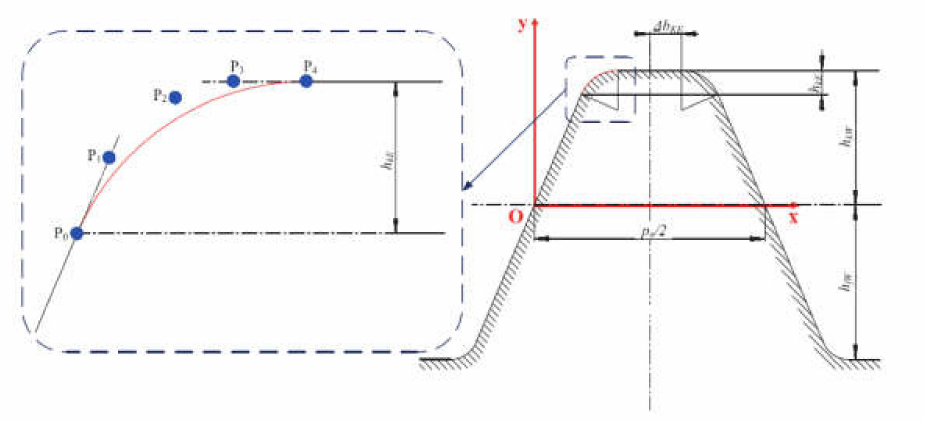
Figure 1. Hob and tip contour replaced by the Bezier curve.